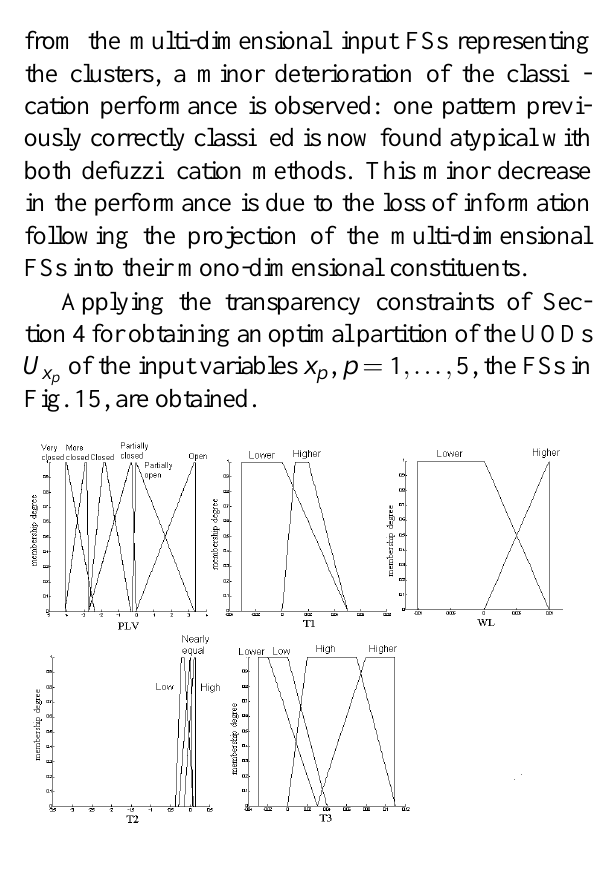
Fig. 15. Final partition of the inputs